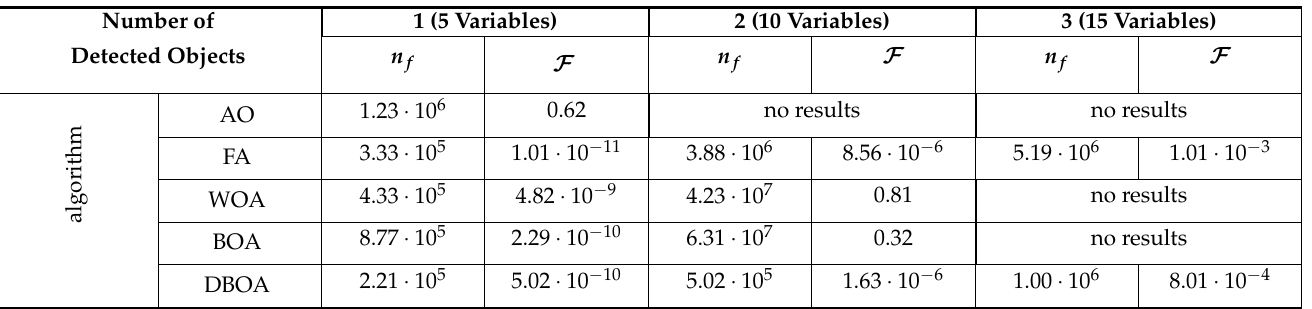
Table 1. Comparison of the number of calls to the objective function ( n f ) and the value of the F function depending on the number of detected objects for the analyzed